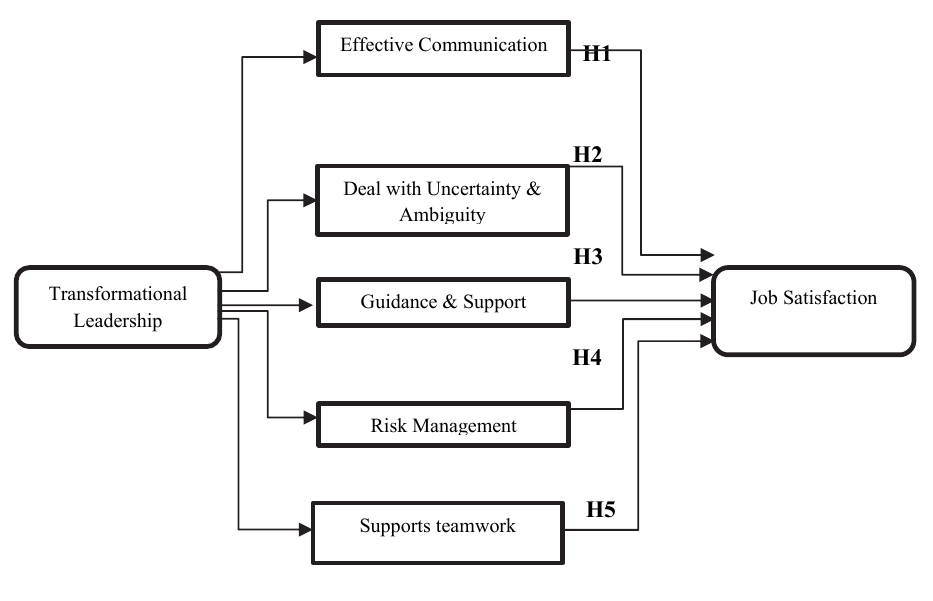
Fig. 1. The Conceptual